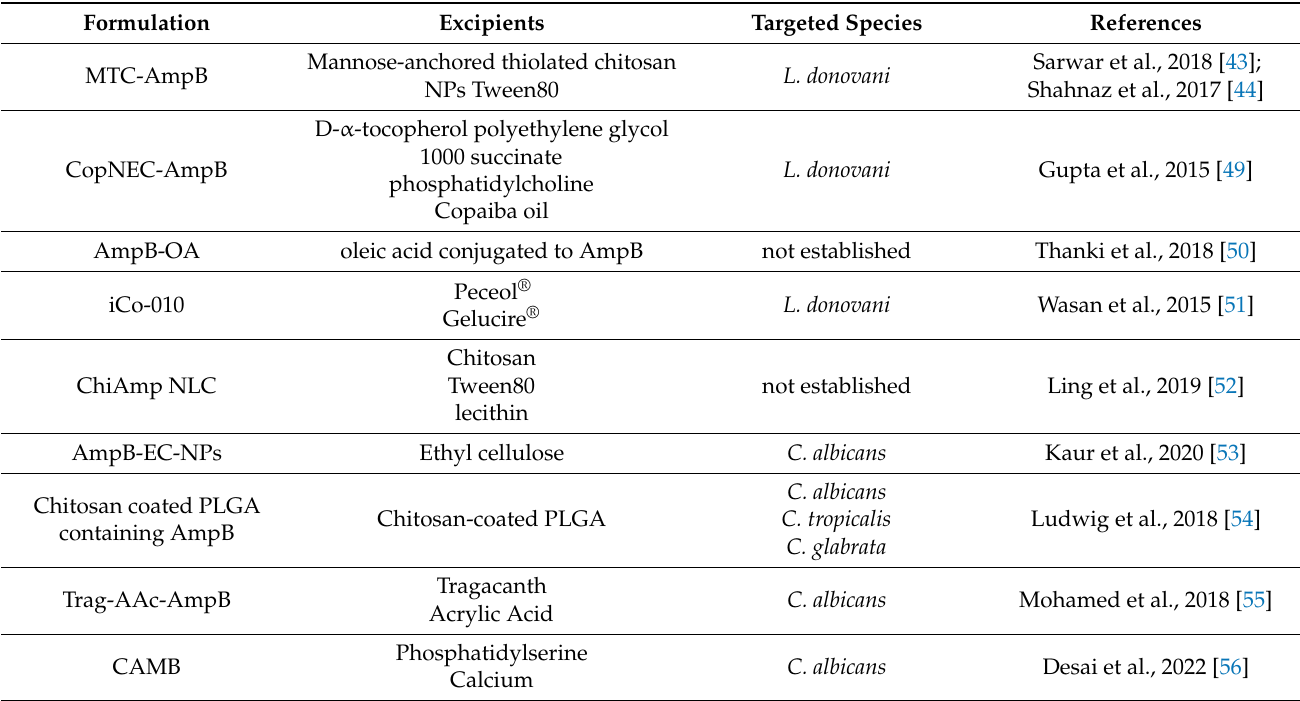
Table 5. Novel oral AmpB